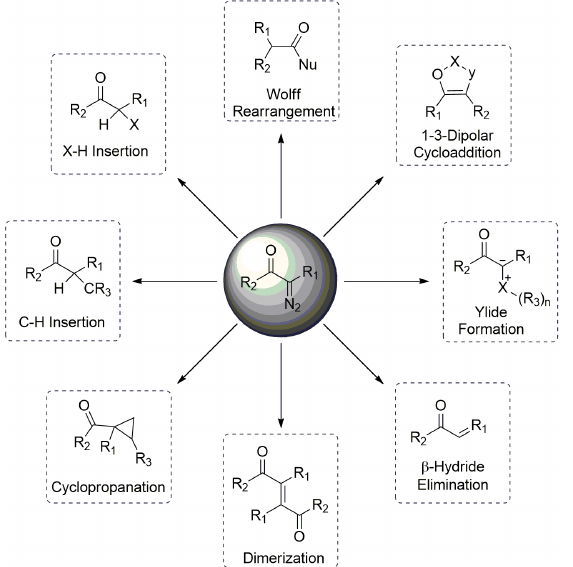
Figure 1 - Some reactions employing diazocarbonyl compounds.